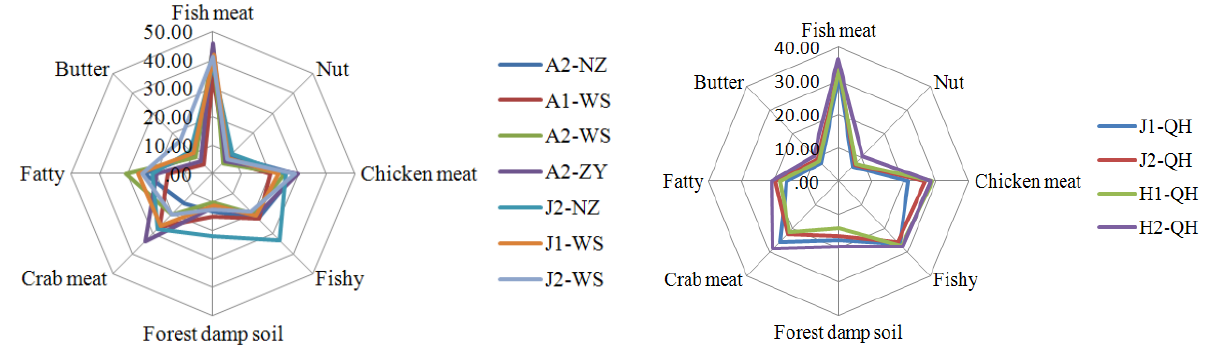
Figure 3. Radar plots for sensory scores of cultured puffer